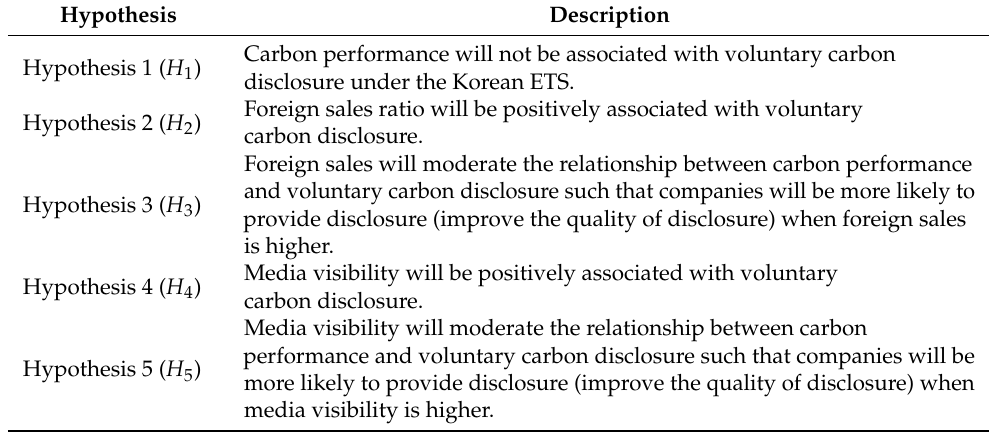
Table 1. Summary of